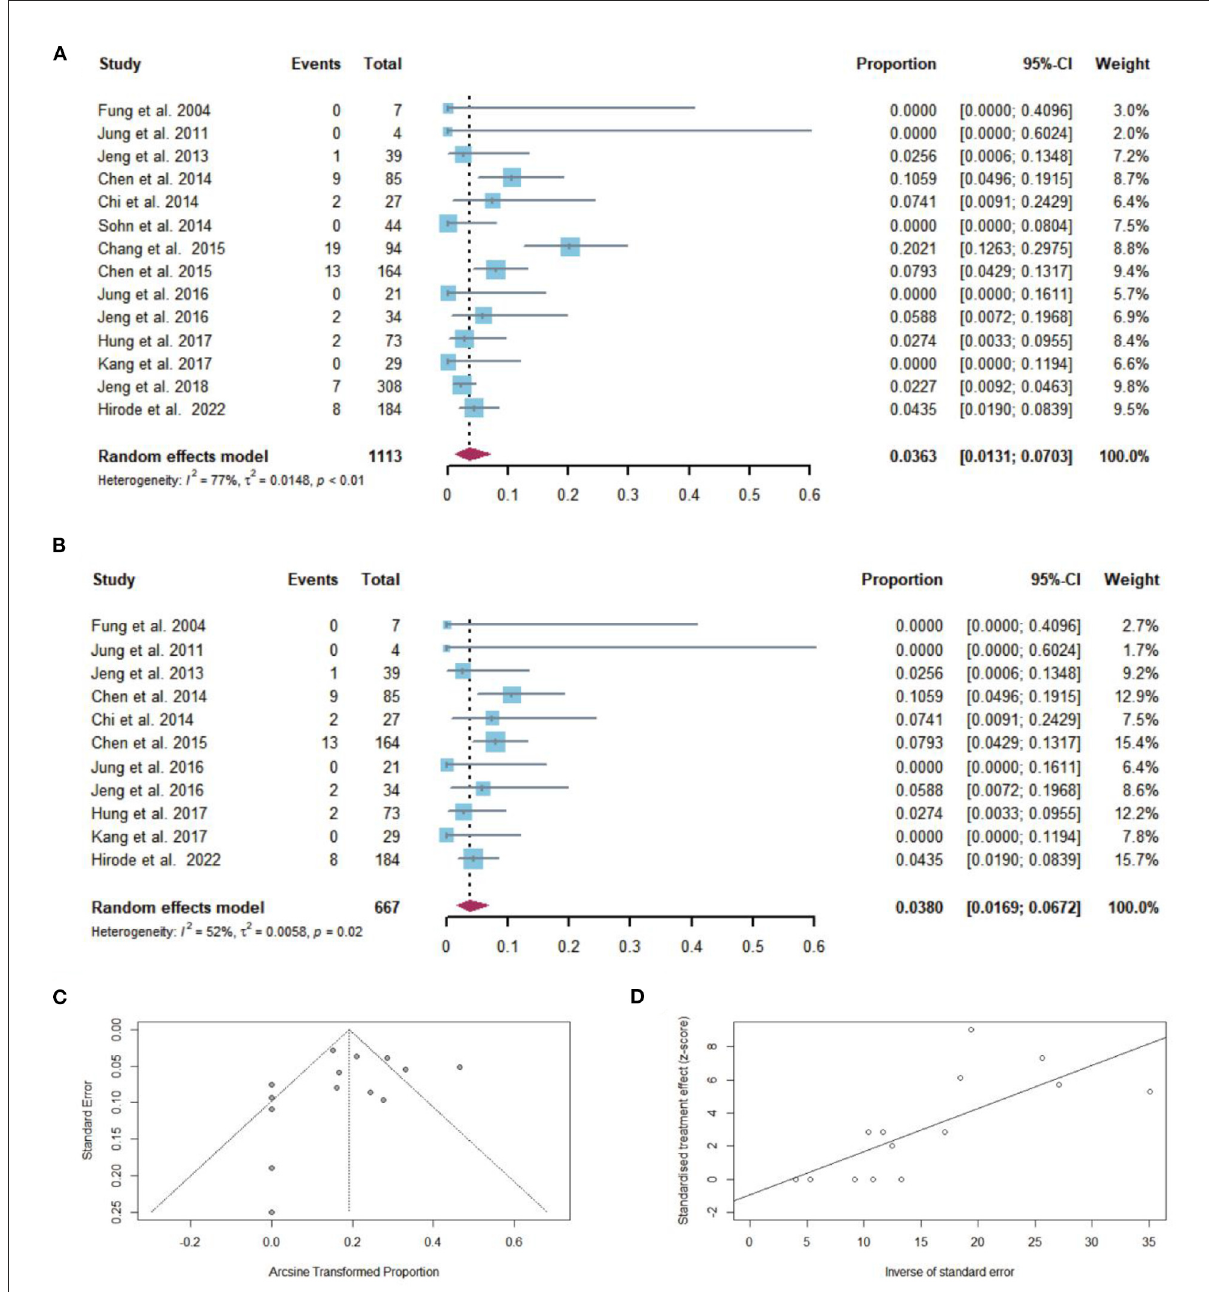
FIGURE7 (A) Individual estimates and pooled proportion of hepatic decompensation in cirrhotic patients after NAs discontinuation. (B) Sensitivity analysis of pooled proportion of hepatic decompensation in cirrhotic patients after NAs discontinuation excluding studies with high bias. (C) Funnel plot. (D) Egger’s